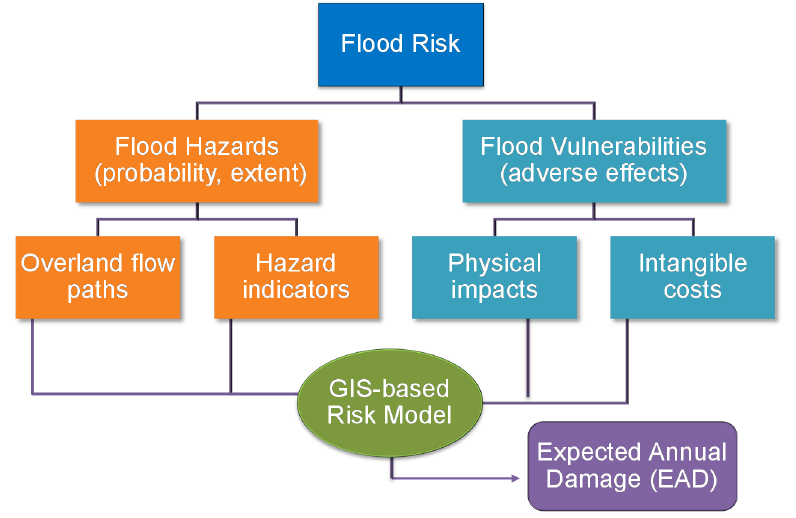
Figure 1. Framework for assessing economic pluvial flood risk